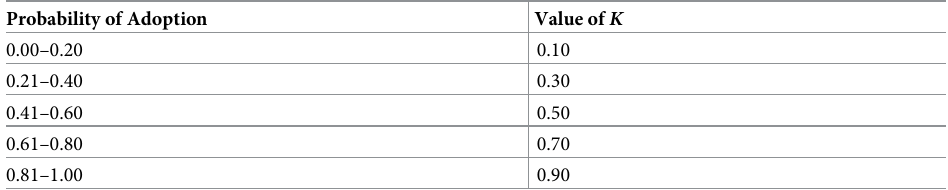
Table 3. Conversion of probability of adoption into K value.